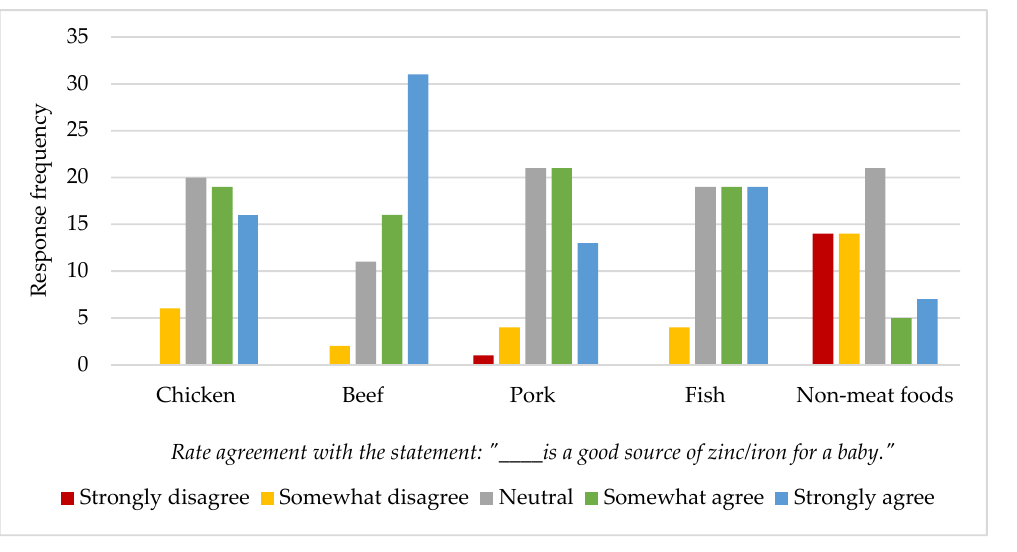
Figure 2. Idaho parent/caregiver’s perception of beef and other foods as a good source of zinc/iron for infants. Subjects were asked in the form of an electronic Qualtrics survey ( n = 61).